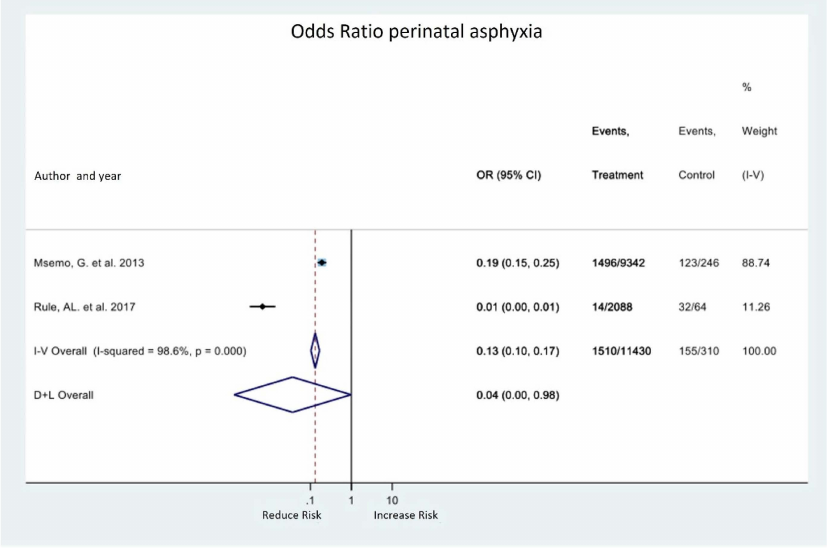
Figure 3. Forest plot for effect of HBB program on neonatal morbidity.